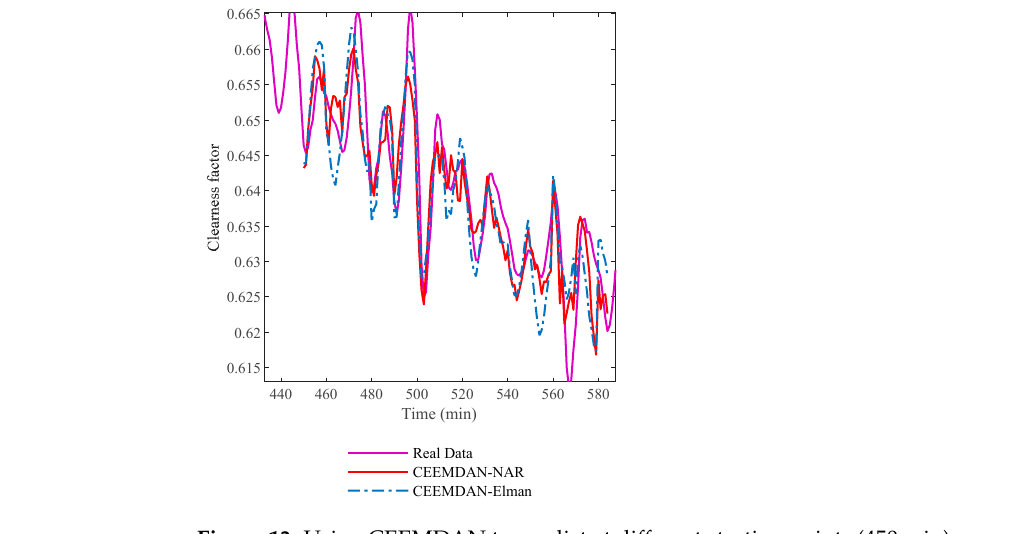
Figure 15. Different prediction starting points (350 min and 450 min) under the evaluation index (RMSE).